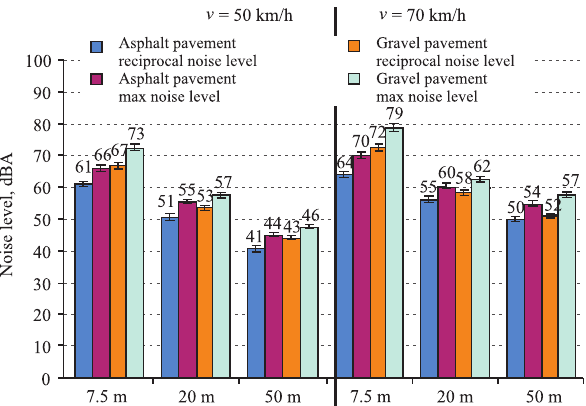
Fig. 11. Dependence of reciprocal and max noise levels on car speed when driving in wooded area on road with asphalt and gravel pavement in